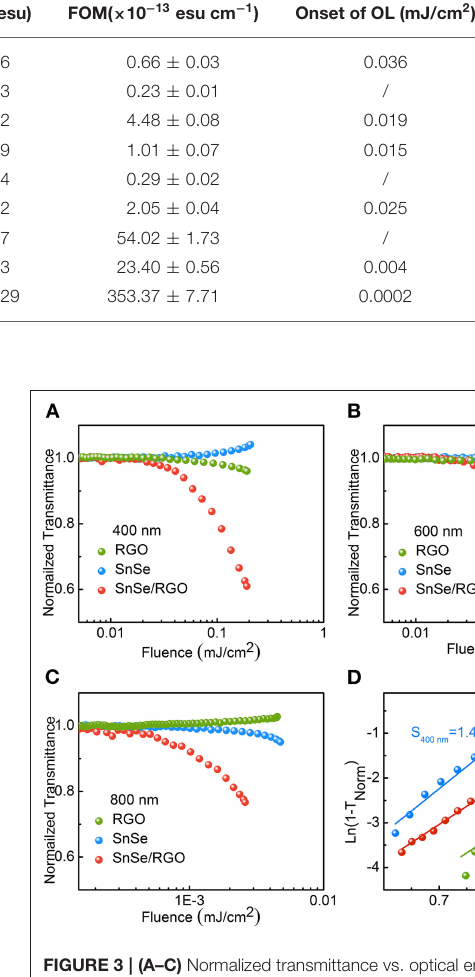
dynamic relaxation. The significant decrease in transmittance indicates a multi-photon-absorption-induced RSA